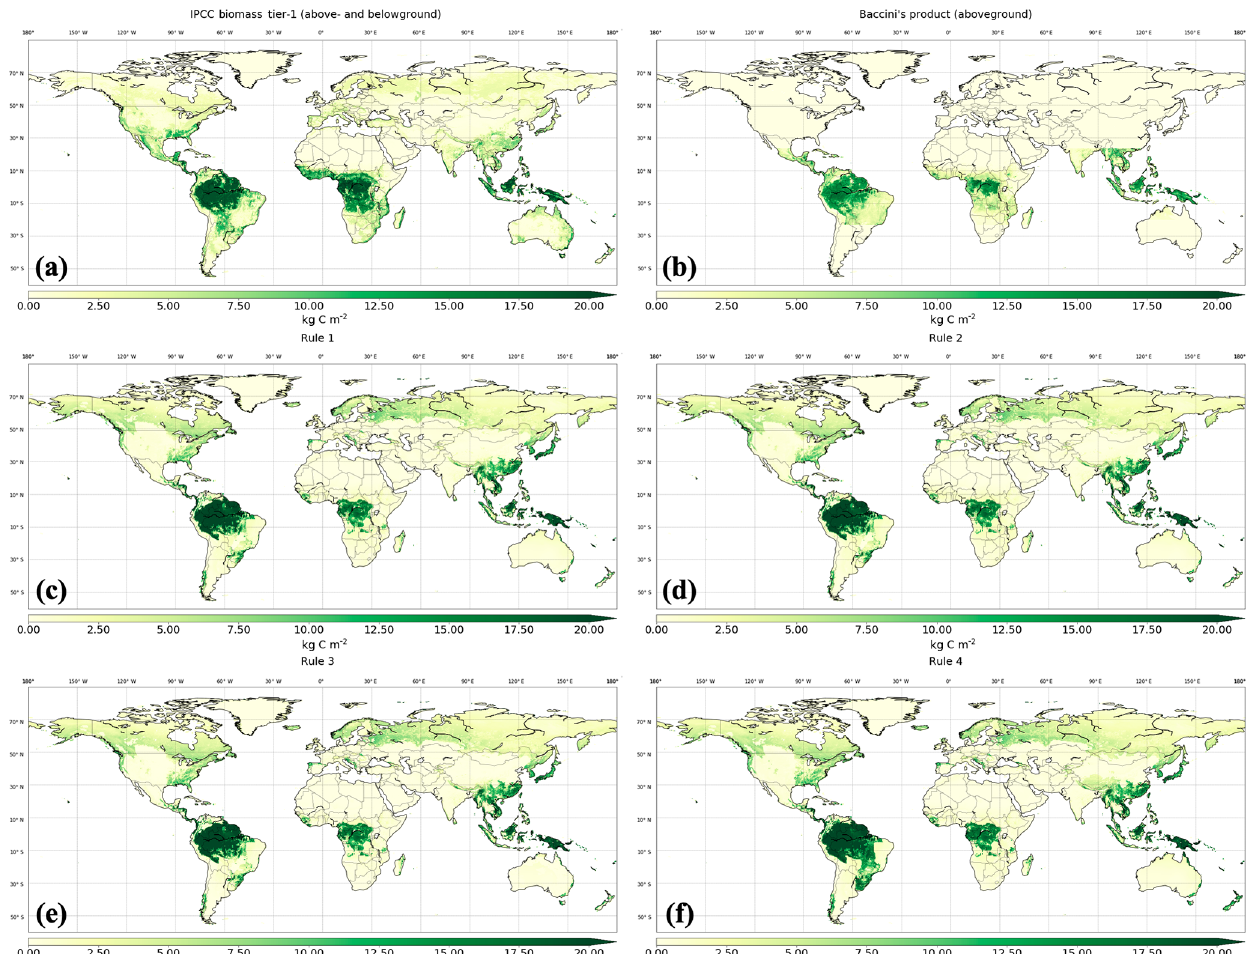
Figure 7. (a) IPCC Tier-1 biomass density; (b) Baccini’s product (only aboveground) at pantropical; global carbon density (above- and belowground) maps estimated by Rules 1–4 from (c) to (f)